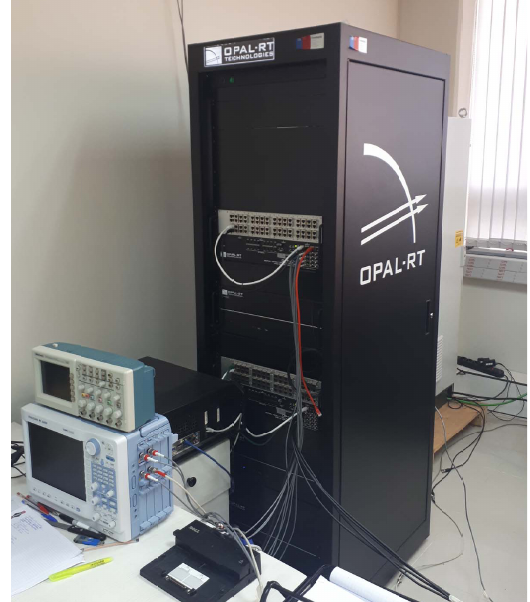
Figure 3. RTS simulator.